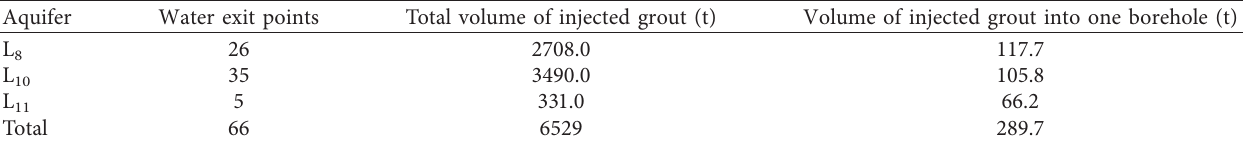
Table 9: Type VI